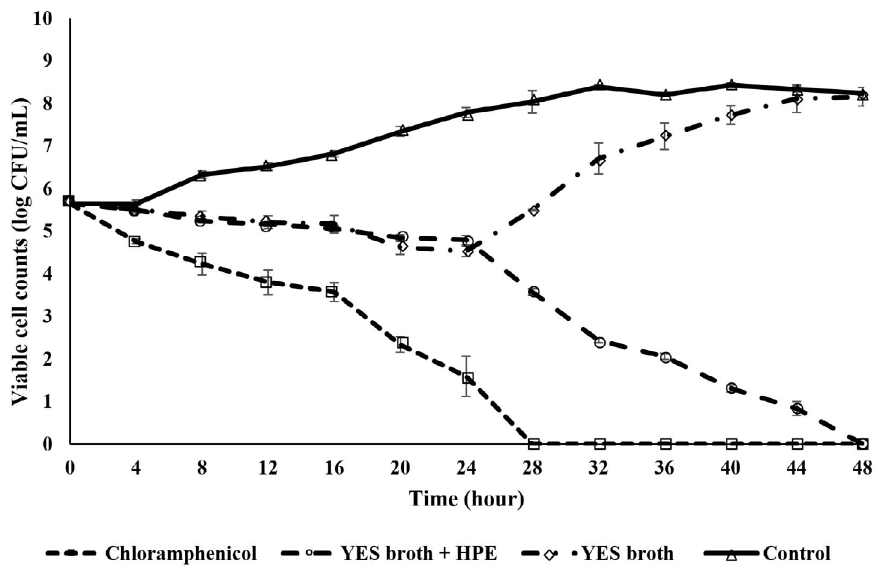
Fig. 1. Time-kill curve of chloramphenicol and various extracts against MRSA ATCC33591. Notes: YES: yeast extract sucrose, HPE: host plant